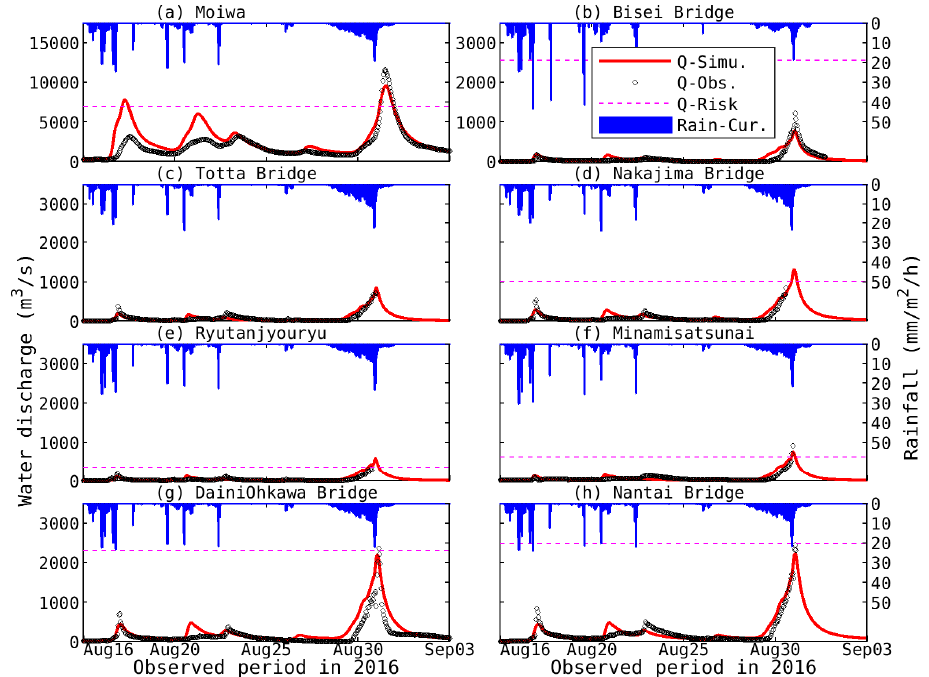
Figure 7. Discharge comparison of the statistical bias-correction. All other information is identical to that in Figure 5.